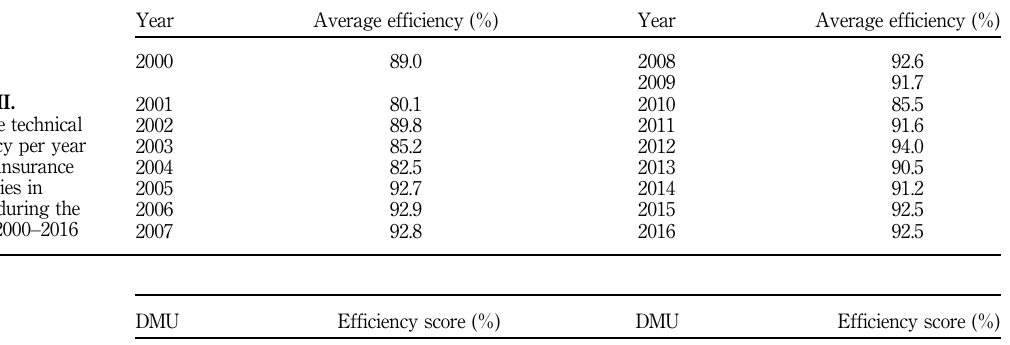
Table III. Average technical efficiency per company for the insurance companies in Jordan during